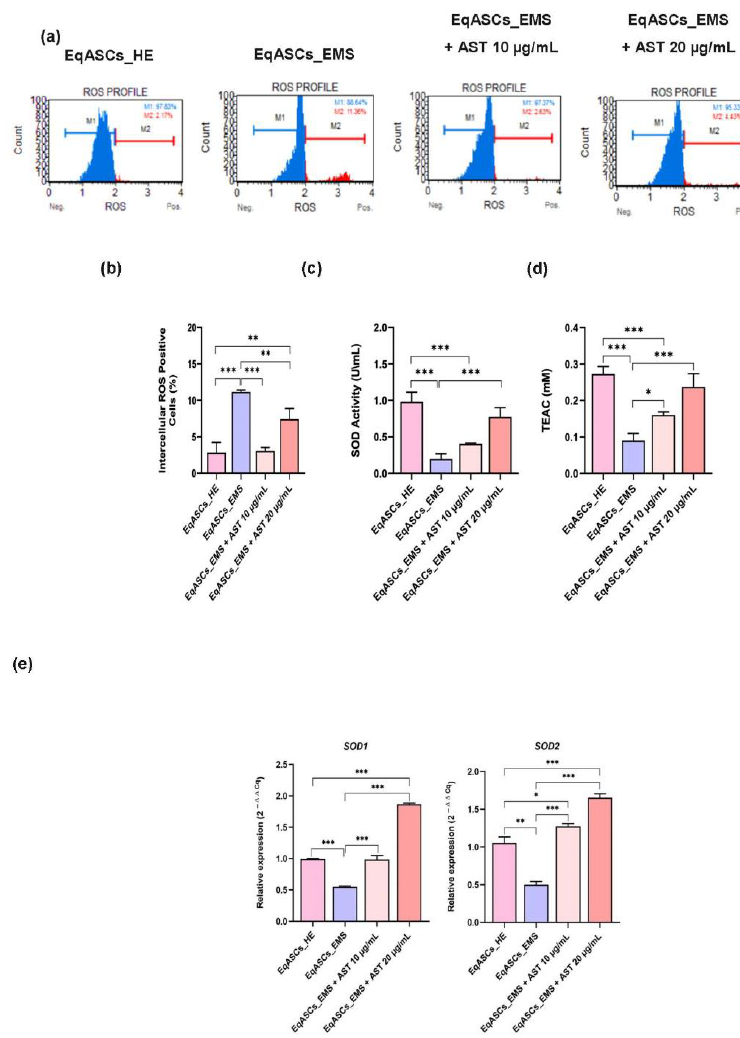
Figure 3. Effect of Astaxanthin on oxidative stress in EMS affected ASC cells. ( a ) Dot-Plots for intracellular ROS production detected by dihydroethidium (DHE) fluorescence staining. ( b ) Average percentages of total ROS+ cells in each experimental group. ( c ) Measurement of SOD Activity performed with Cayman Superoxidase Dismutase Assay Kit ( d ) antioxidant capacity by Cayman’s Antioxidant Assay Kit. ( e ) Rel- ative gene expression of SOD1 and SOD2 transcripts. A comparison of EMS, treatment groups and un- treated healthy cells is shown by an asterisk (*). * p < 0.05, ** p < 0.01, *** p < 0.001.